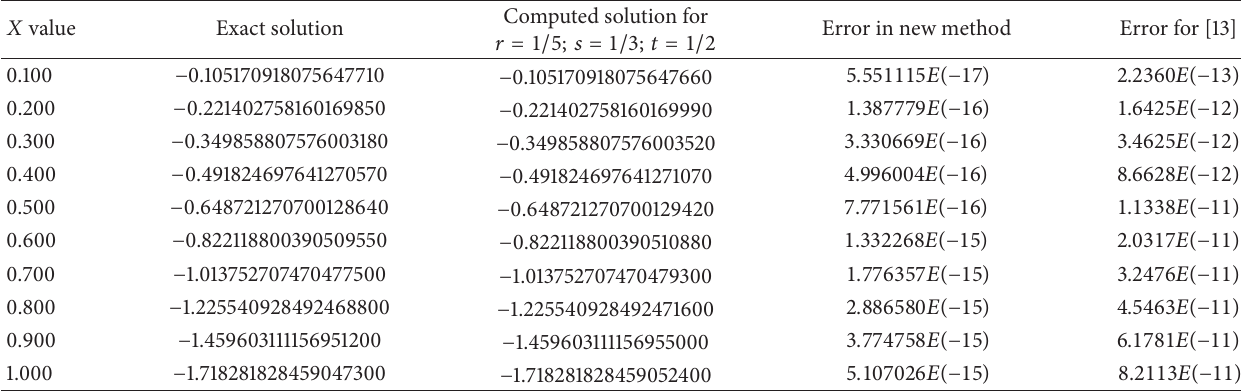
Table 3: Comparison of the proposed method with [13].